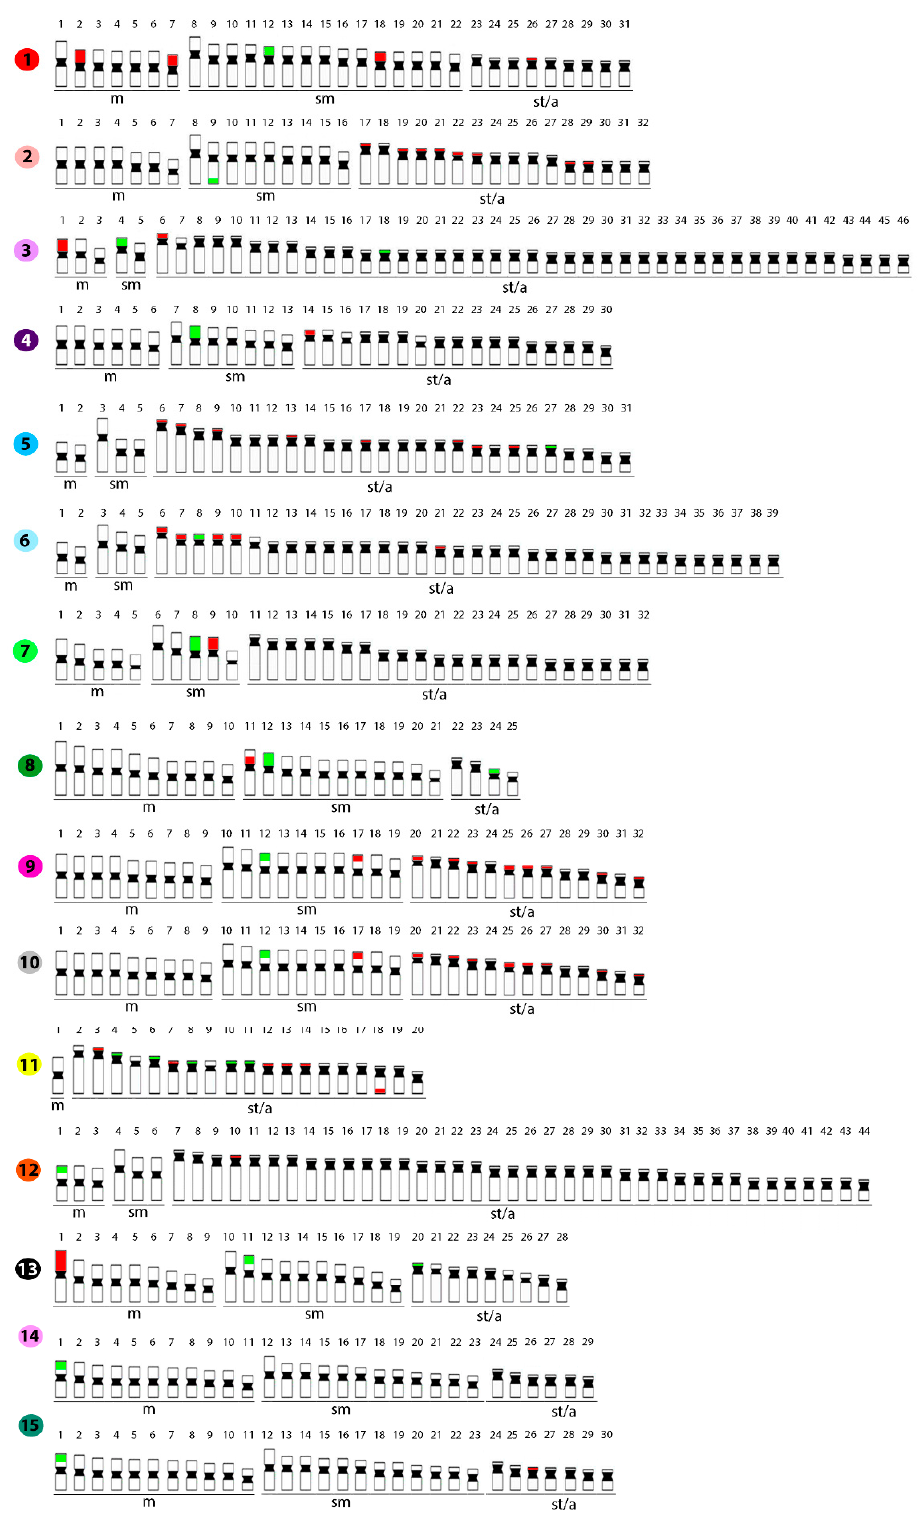
Figure 5. Representative idiograms of Belodontichthys truncates ( 1 ); Kryptopterus bicirrhis ( 2 ); Kryptopterus giminus ( 3 ); Kryptopterus limpok ( 4 ); Kryptopterus microcephalus ( 5 ); Micronema cheveyi ( 6 ); Ompok fumidus ( 7 ); Ompok siluroides ( 8 ); Phalacronotus apogon ( 9 ); Phalacronotus bleekeri ( 10 ); Silurichthys phaiosoma ( 11 ); Wallago attu ( 12 ); Wallago micropogon ( 13 ); Silurus aristotelis ( 14 ); and Silurus glanis ( 15 ), showing the distribution of the 5S (red) and 18S (green) rDNA sites on the respective chromosomes (except for S. aristotelis , where only 18S rDNA is indicated).